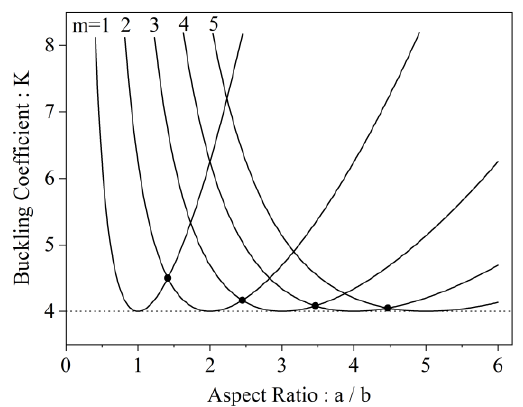
Figure 1. Compressive buckling coefficient curves for m = 1 through m = 5. Dots represent points of intersection between curves.